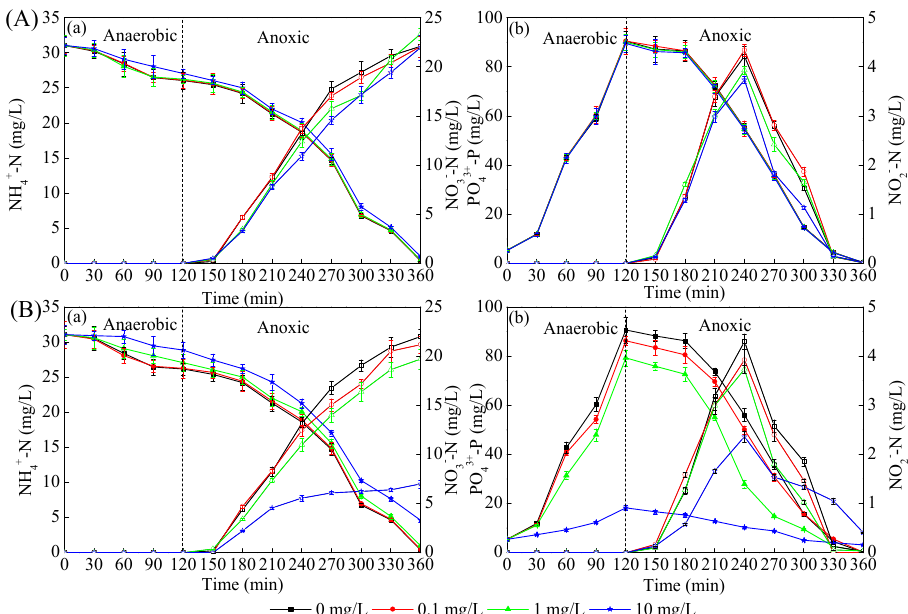
Figure 3. Effects of CeO 2 NPs on the variations of ( a ) NH 4+ -N (full) and NO 3 − -N (blank), ( b ) PO 43+ -P (full) and NO 2 − -N (blank) during one cycle after 1 day ( A ) and 10 weeks ( B ) of exposure to 0 (black), 0.1 (red), 1 (green), and 10 (blue) mg/L CeO 2 NPs, respectively. Error bars represent standard deviations of triplicate measurement.